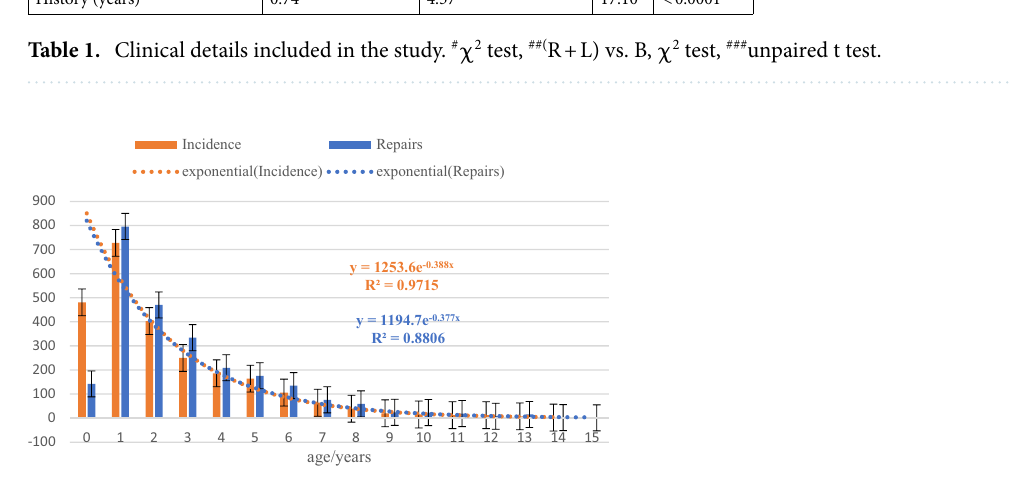
Figure 2. Trend chart of onset and treatment ages in children. Within a few years of birth, both incidence and repairs declined rapidly.